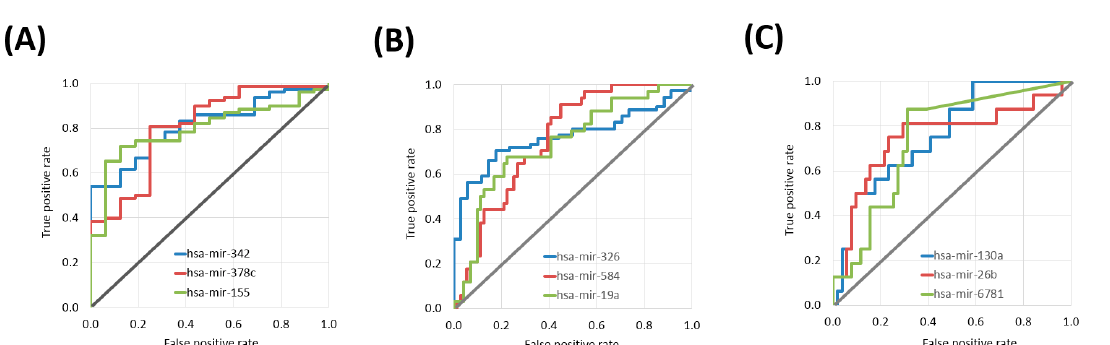
Figure 1. ROC curves of the top three miRNAs with predictive power in platinum treatment in different tumor tissues including cervical cancer samples ( A ), head and neck cancer ( B ), and lung squamous cell carcinoma ( C ). In the HNSC cohort 103 differentially expressed miRNAs associated with treatment outcome. The top three miRNAs were hsa-miR-326 ( p value: 9.24 × 10 − 6 , AUC: 0.768), hsa-miR-584 ( p value: 2.02 × 10 − 5 , AUC: 0.758) and hsa-miR-19a ( p value: 4.66 × 10 − 5 , AUC: 0.742) (Table 3 and Figure 1B).